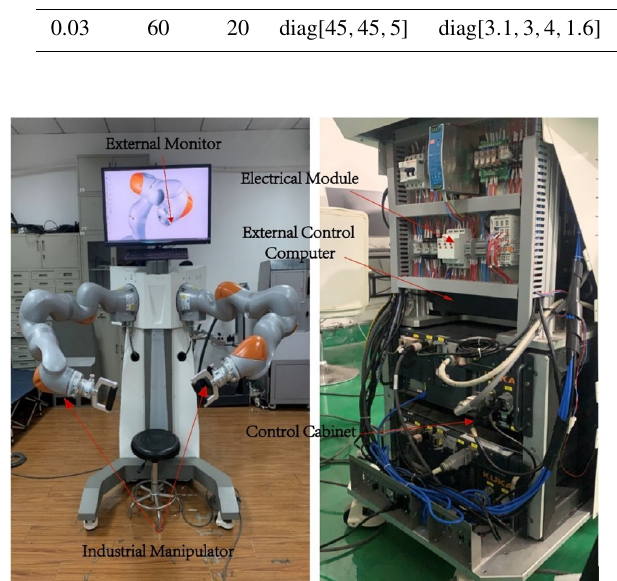
Figure 4. Architecture and major components of the end-effector upper-limb rehabilitation robot (EULRR) system.